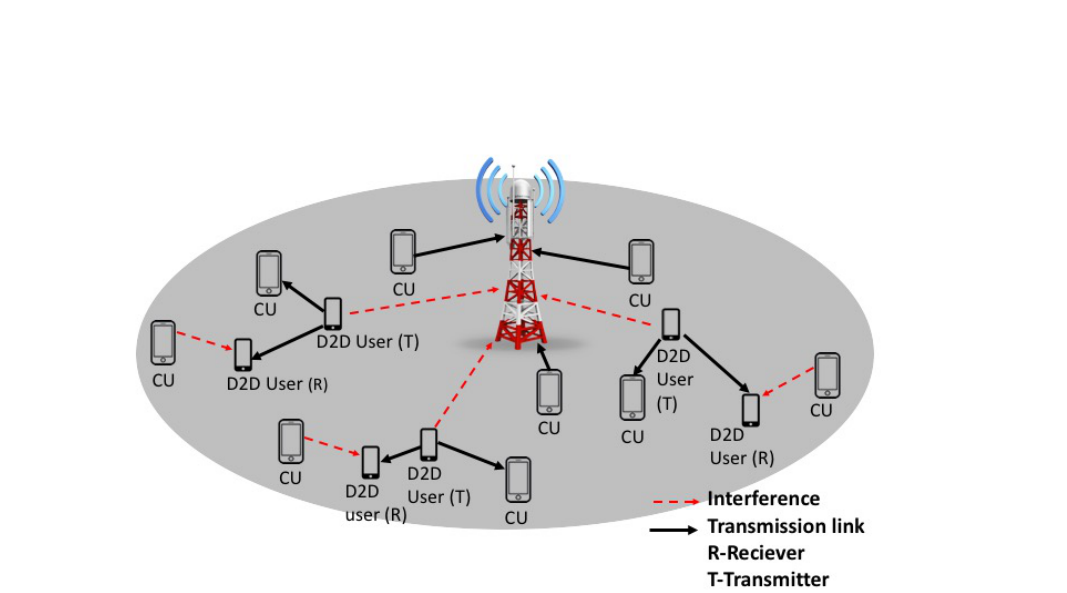
Figure 1. System model comprised of a cellular base station (CBS) and D2D pairs. CU, cellular